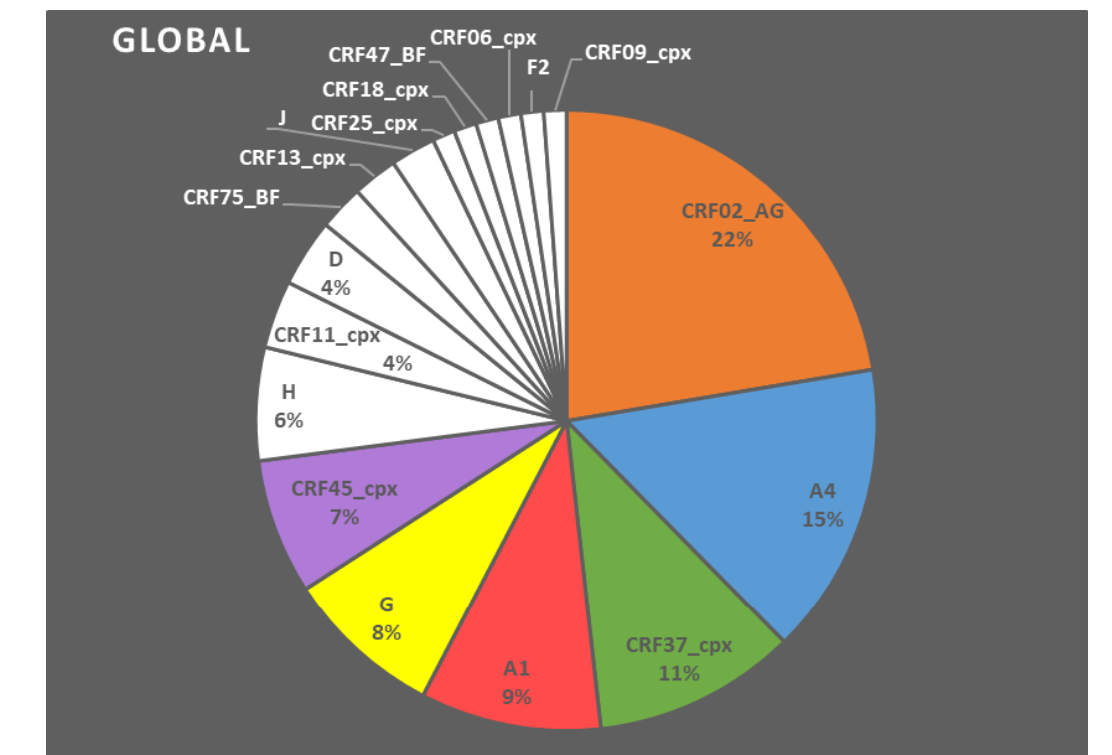
Figure 2. Global analysis of the HIV subtypes diversity according to the genotyping of the pol region. CRF means circulating recombinant form.